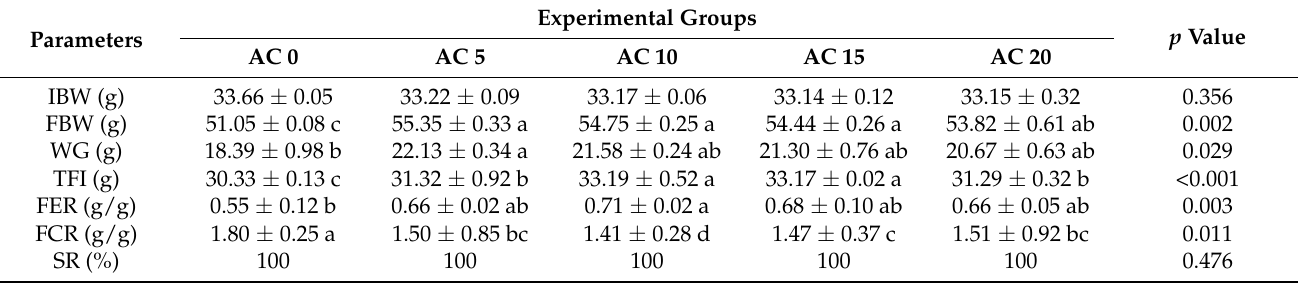
IBW: initial body weight, FBW: final body weight, WG: weight gain, TFI: total feed intake, FER: feed efficiency ratio, FCR: feed conversion ratio, SR: survival rate. Values in the same row showing different letters are statistically significantly different ( p < 0.05). Data are presented as the mean ±